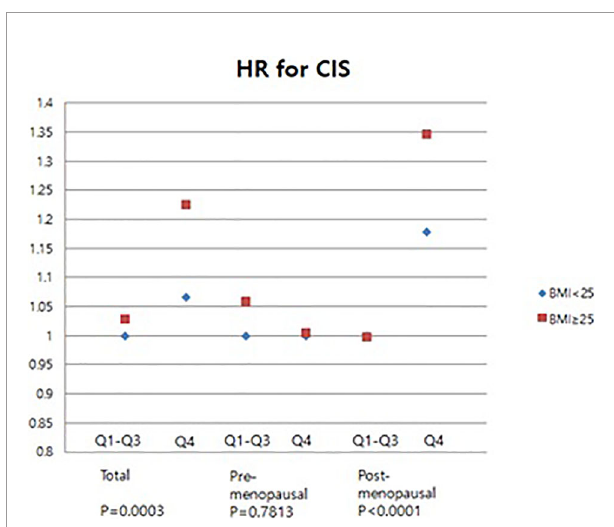
FIGURE 5 | Association of levels of GGT with carcinoma in situ of breast in pre- and post-menopausal women by